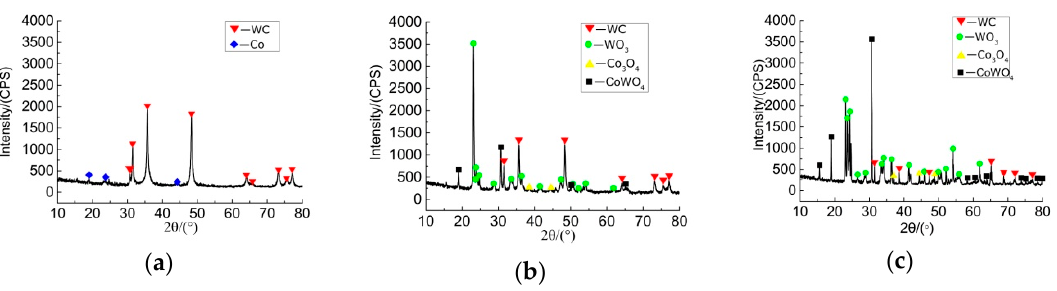
Figure 2. X-ray diffraction (XRD) patterns of WC/Co at different temperatures: ( a ) 873 K, WC: PDF#65-4539; Co: PDF#65-9722; ( b ) 973 K, WO 3 : PDF#71-0305; CoWO 4 : PDF#72-0479; Co 3 O 4 : PDF#42-1467; WC: PDF#65-4539; and ( c ) 1273 K, Co 3 O 4 : PDF#42-1467; CoWO 4 : PDF#72-0479; WO 3 : PDF#71-0305; WC: